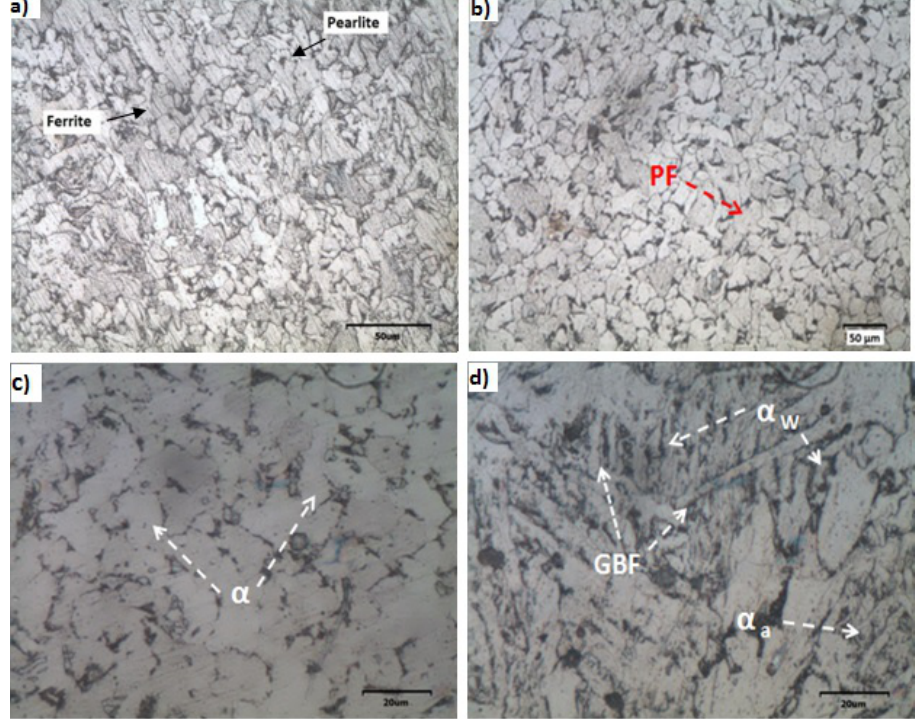
Figure 10: Optical micrographs of WAAM component, a) primary microstructure of ER70S-6, b) in bottom region, c) in top region with lower magnification and d) in top region in higher